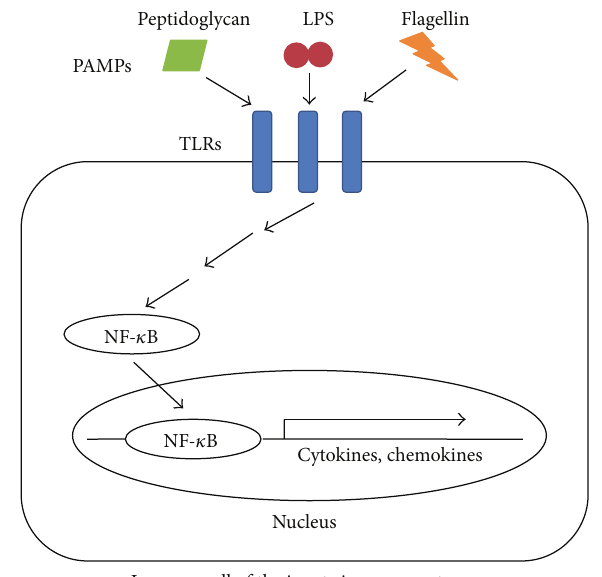
Figure 1: Initiation of the immune response following infection. Immune cells of the innate immune system recognize invading pathogens via Toll-like receptors (TLRs). The binding of pathogen- associated molecular patterns (PAMPs), such as peptidoglycan, lipopolysaccharide (LPS), or flagellin, to TLRs initiates signal transduction cascades that lead to the activation of nuclear factor 𝜅 B (NF- 𝜅 B). NF- 𝜅 B is subsequently translocated into the nucleus where it induces the expression of cytokines and